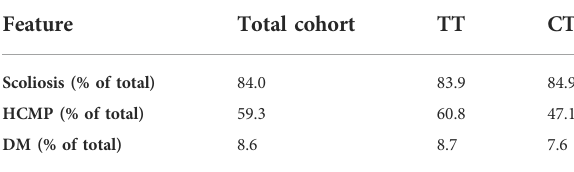
TABLE 4 SIRT6 genotype does not in fl uence the prevalence of scoliosis, hypertrophic cardiomyopathy, or diabetes in FRDA. Prevalence of scoliosis, hypertrophic cardiomyopathy (HCMP), and diabetes mellitus (DM) in the total cohort and both sub-cohorts TT and CT. Fisher ’ s exact test was used to statically analyze each feature between TT and CT sub-groups. All comparisons